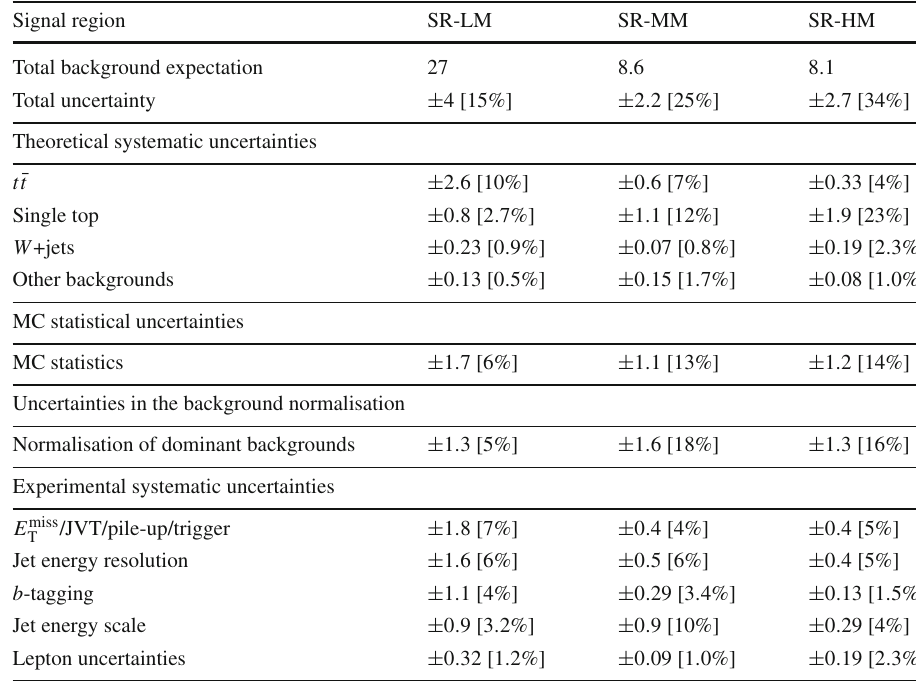
dominant systematic uncertainties in